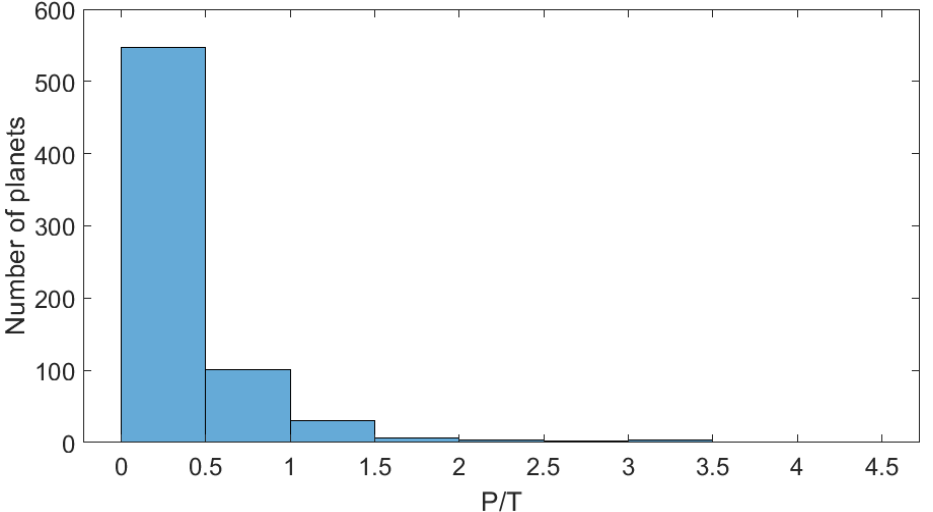
Figure 3. The distribution of RV planets over the ratio of the orbital period P to the total time of observations T